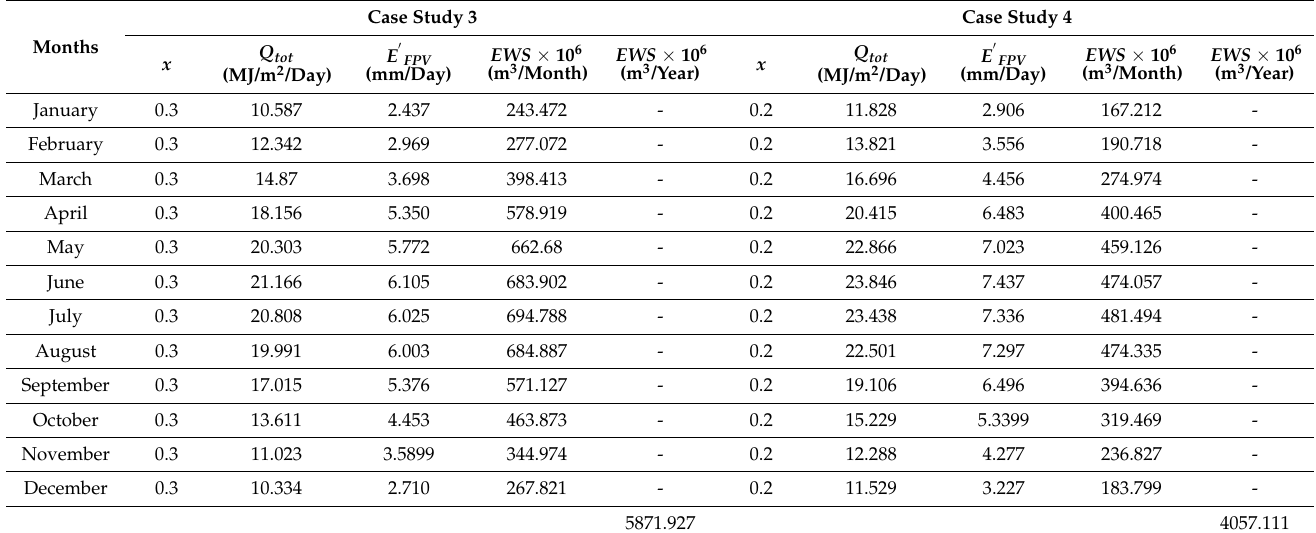
Table 3. Water evaporation savings results (Case Study 3 and Case Study 4).